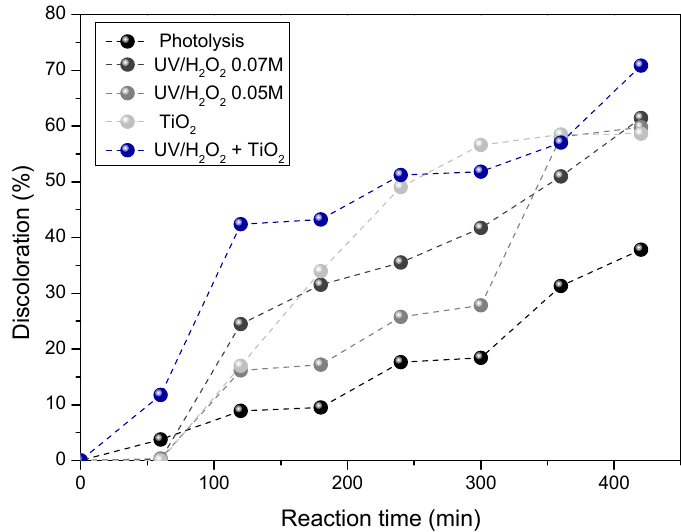
Figure 4. Stained wastewater discoloration under different AOPs.